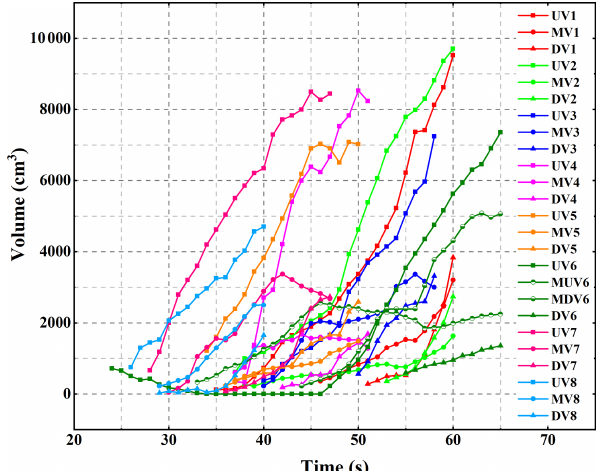
Figure 7. Volumes of boulder bars. Notation: UV, MV, DV, MUV, and MDV represent the volume of the boulder bar near the up- stream reaches, the boulder bar near the middle reaches, the boulder bar near the downstream reaches, the boulder bar near the middle- upstream reaches, and the boulder bar near the middle-downstream reaches, respectively. Digits 1 to 8 indicate the T1 to T8 texts, re- spectively. For example, UV1 means the volume of the boulder bar near the upstream reaches of the T1 test.